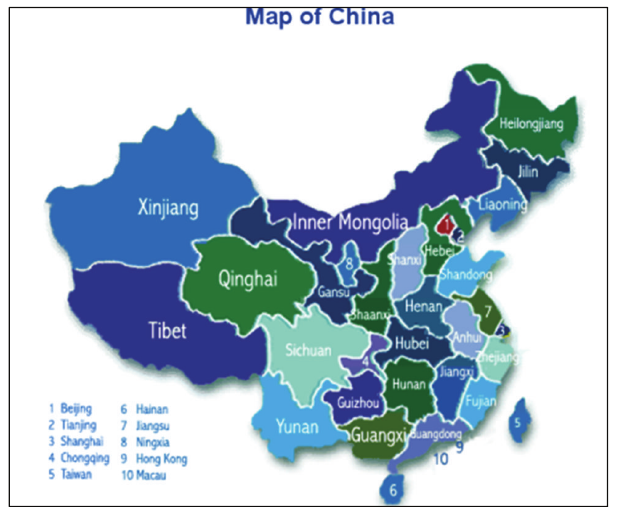
Figure 1: Provincial map of China showing the location of Jiangsu province, adopted from